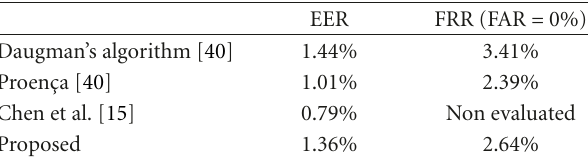
Table 4: Performances reached by our local analysis method, compared with the